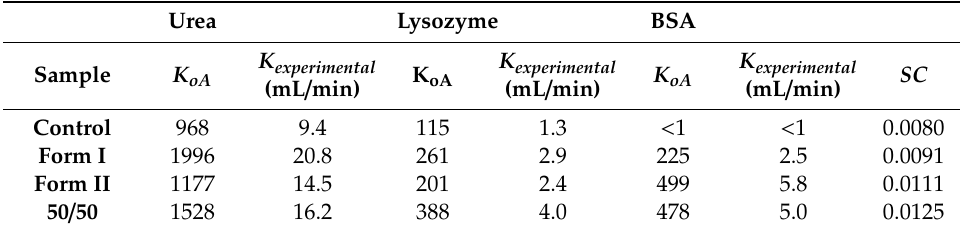
Table 2. Experimental values for membrane clearance of di ff erent molecules, and their respected K oA , for the four membrane materials with the bovine albumin sieving coe ffi cient (SC) at a flow rate of 200 mL / min and dialysate flow rate of 300 mL /